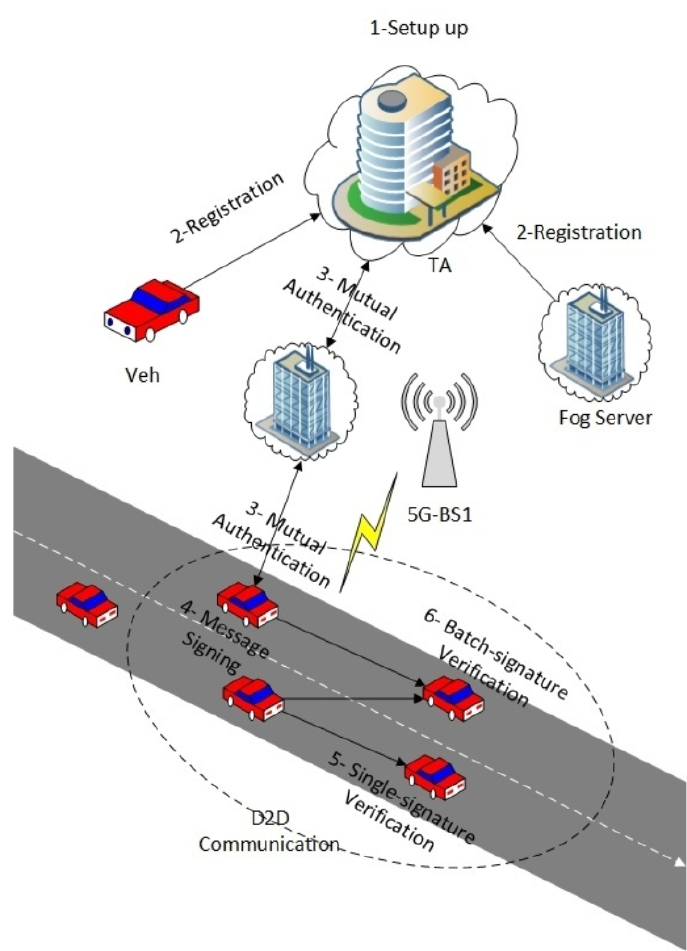
Figure 2. Overall Flow Chart of the Proposed FC-CPPA Scheme